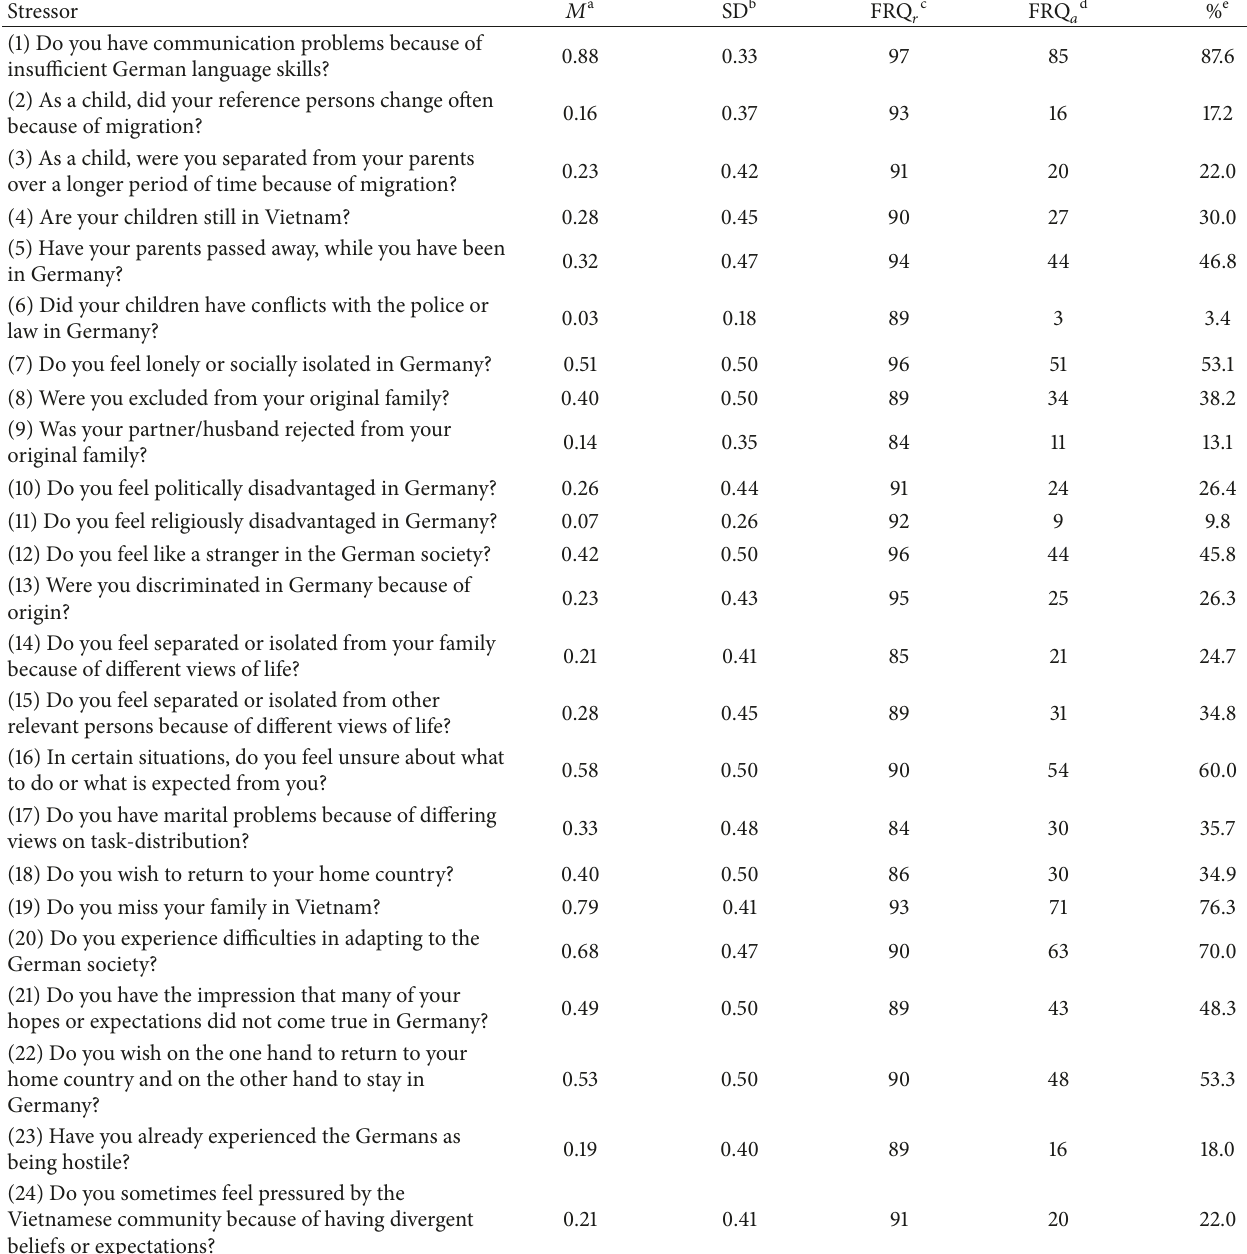
Table 2: Prevalence rates for the 24 migration-related stressor items (adapted from Lujic 2008).